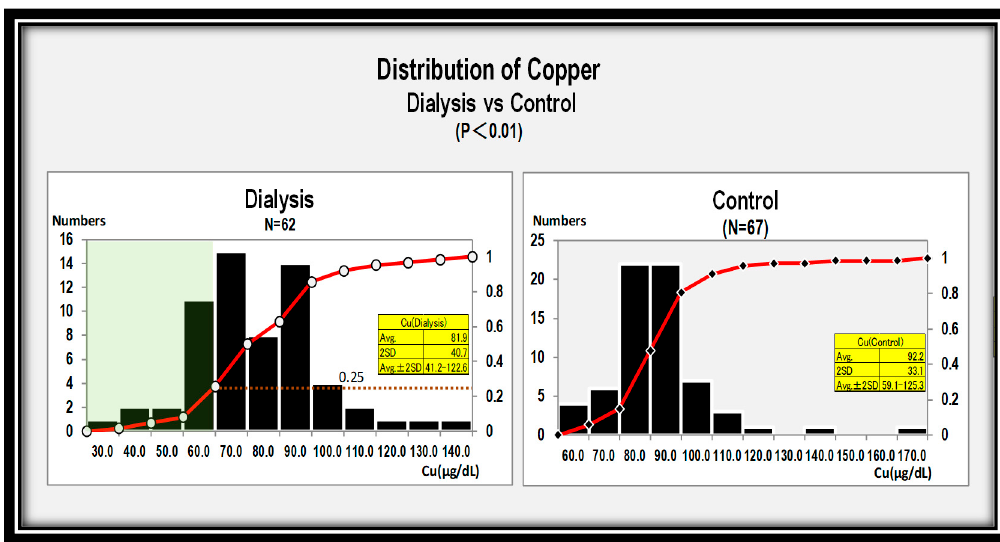
Figure 2. Distributions of copper levels in the dialysis group (left panel) and in the control group (right panel). Copper levels differed slightly between both groups ( P < 0.01).